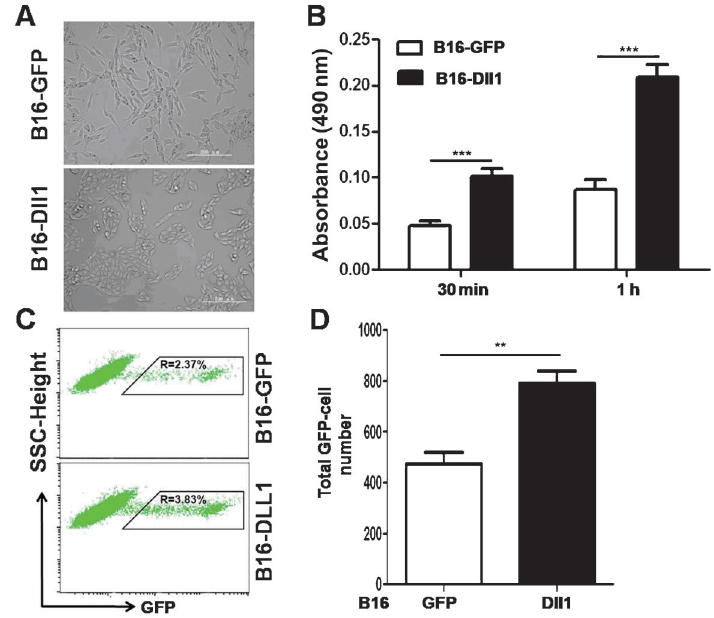
hesion assays were performed. As shown in Figure 2B, the